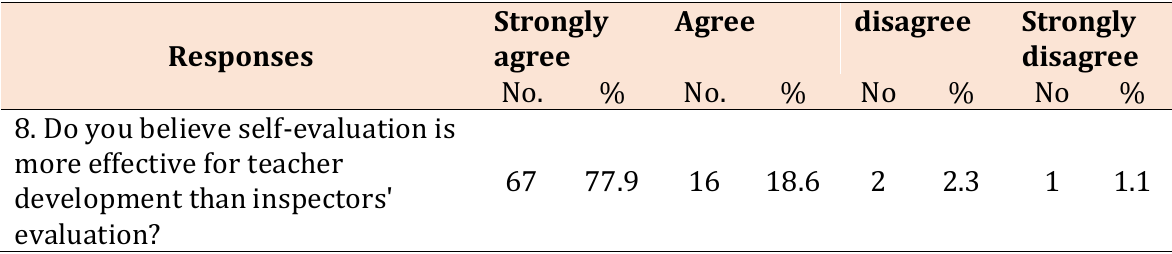
Table 2. Teachers' responses about self-evaluation effectiveness ( questionnaire item